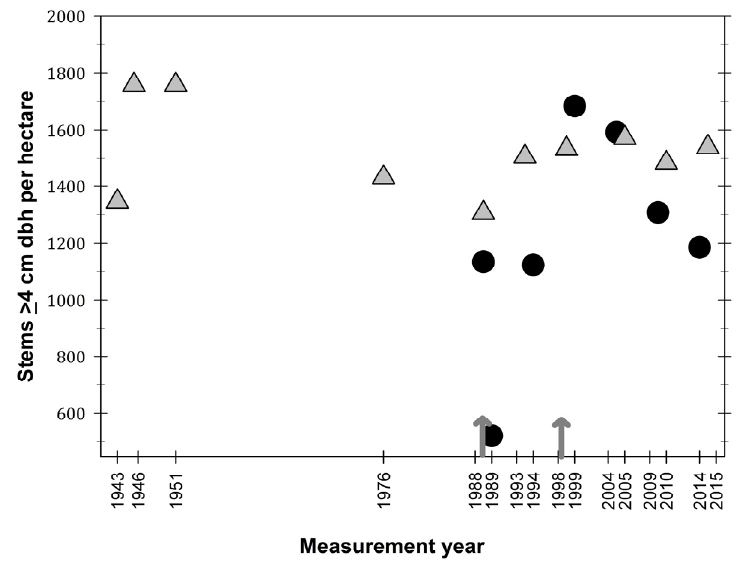
Figure 3. Density of stems ( ≥ 4 cm dbh) per hectare in the El Verde permanent plot (grey triangles) and in Bisley (filled circles), Luquillo Experimental Forest, Puerto Rico. Arrows represent hurricane Hugo (1989) and Georges (1998).